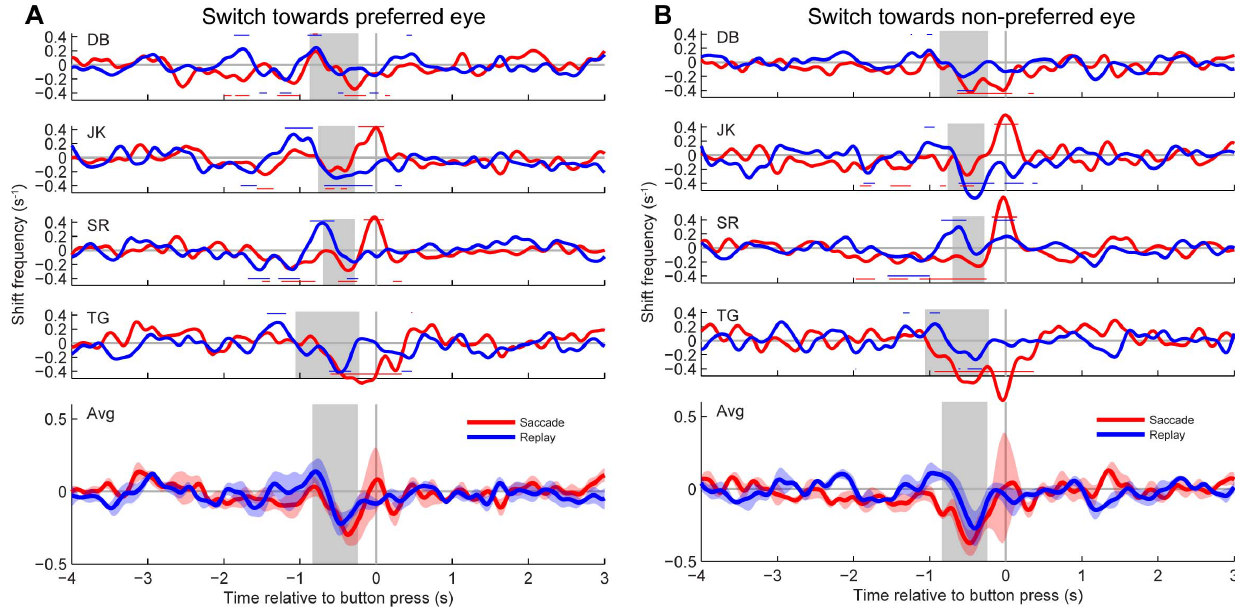
Figure 6. Covariograms of percept switches and small ( , 1 6 ) retinal image shifts. Shifts were produced by saccades (red) or stimulus jumps (blue). A: Switches toward the preferred eye. B: Switches towards the non-preferred eye. Same lay-out as Figure 5, but note the different scaling of the vertical axes.